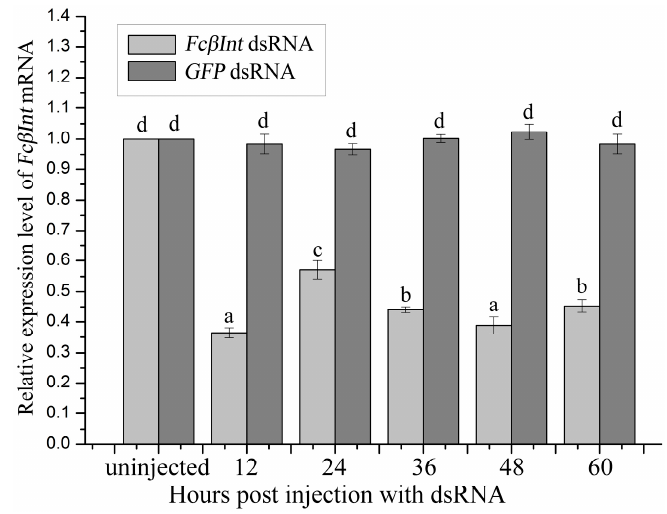
Figure 6. Effects of dsRNA-mediated Fc β Int silencing in shrimp hemocytes detected by qRT-PCR. Significant differences ( p < 0.05) between groups are marked with different letters above bars. Each symbol and vertical bars represented the mean ± SD ( n = 3).